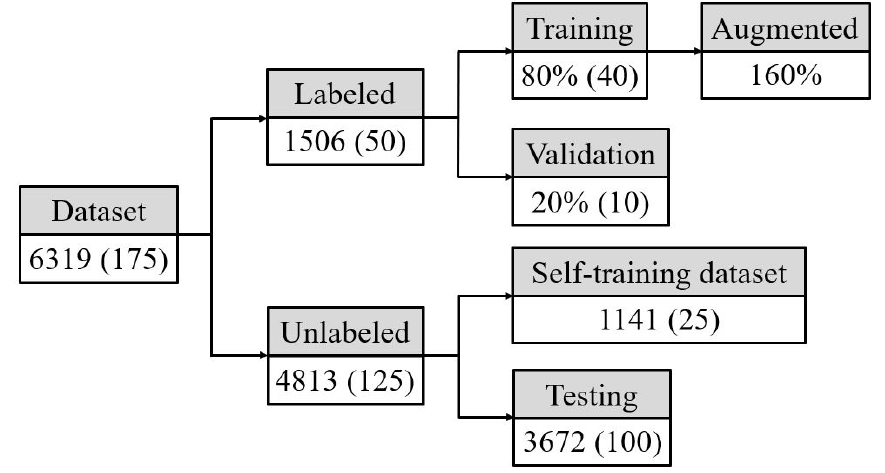
Figure 2. Dataset allocation diagram.